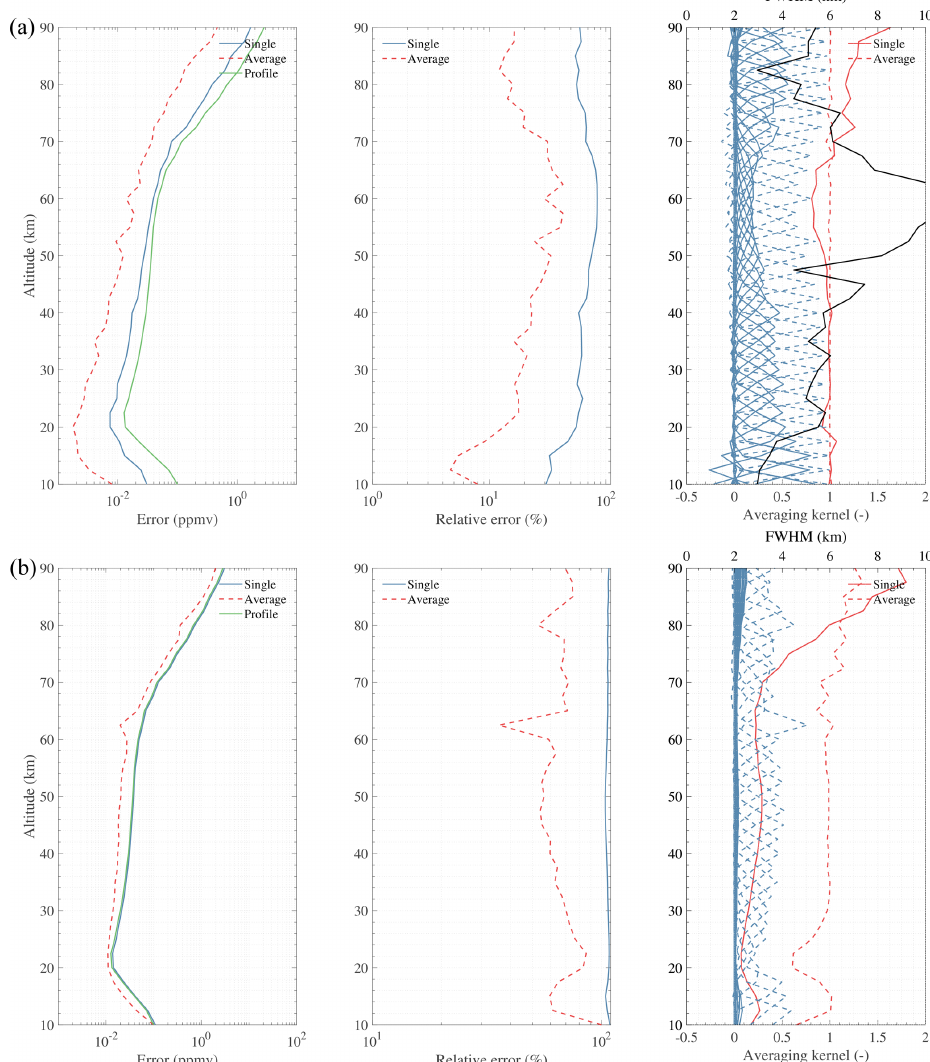
Figure 19. Simulation results of CO retrieval using 230.538 (a) and 661.07GHz (b) lines. “Single” and “Average” represent the retrieval error using different noise. “Profile” represents the typical profile used in the simulation. The black solid line in the last panel represents the FWHM (i.e. vertical